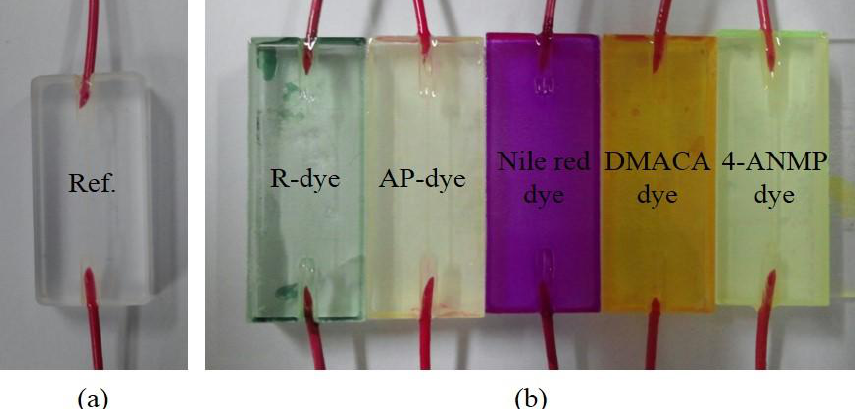
Figure 4. Photograph of the fabricated side-polished optical-fiber device ( a ) before and ( b ) after depositing the sensing